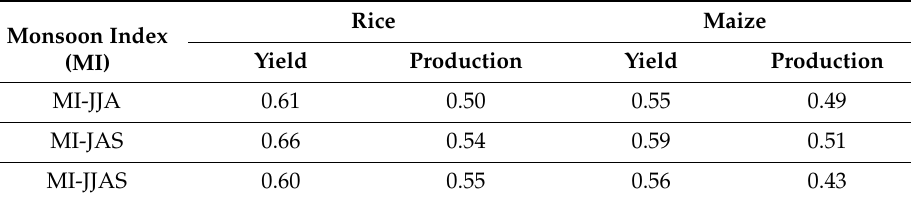
Table 3. Monsoon Index (MI) with 5-year running mean of rice and maize.